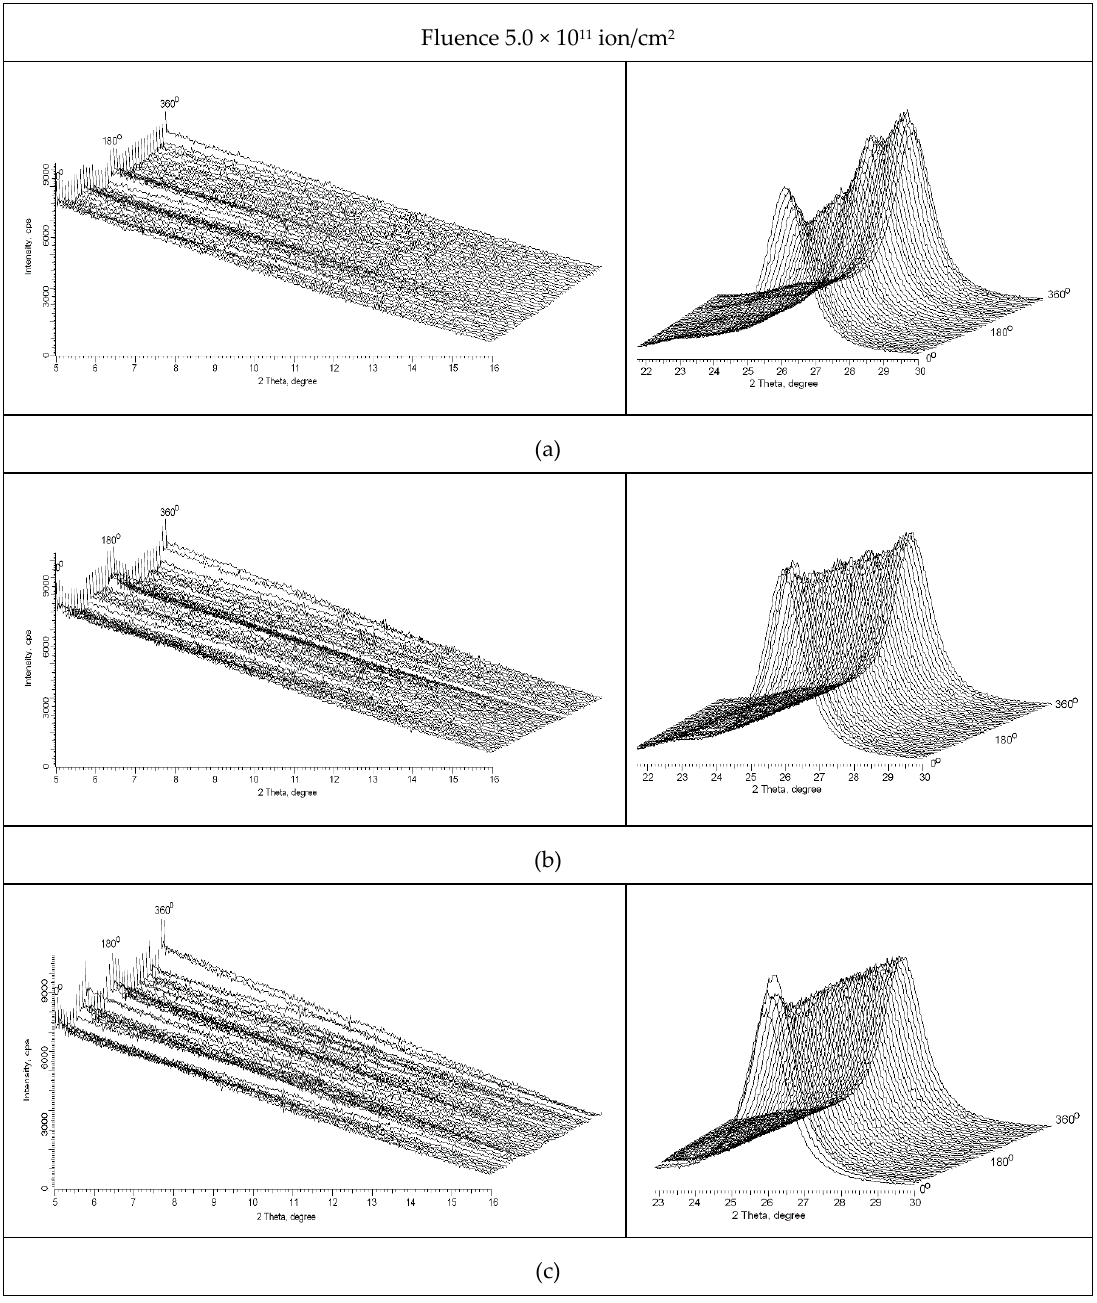
Figure 7. X-ray diffraction patterns of test samples polymer films: ( a ) irradiated Kr 13+ ions; ( b ) Figure 7. X-ray di ff raction patterns of test samples polymer films: ( a ) irradiated Kr 13 + ions; ( b ) irradiated irradiated Kr 14+ ions; ( c ) irradiated Kr 15+ ions. Kr 14 + ions; ( c ) irradiated Kr 15 +